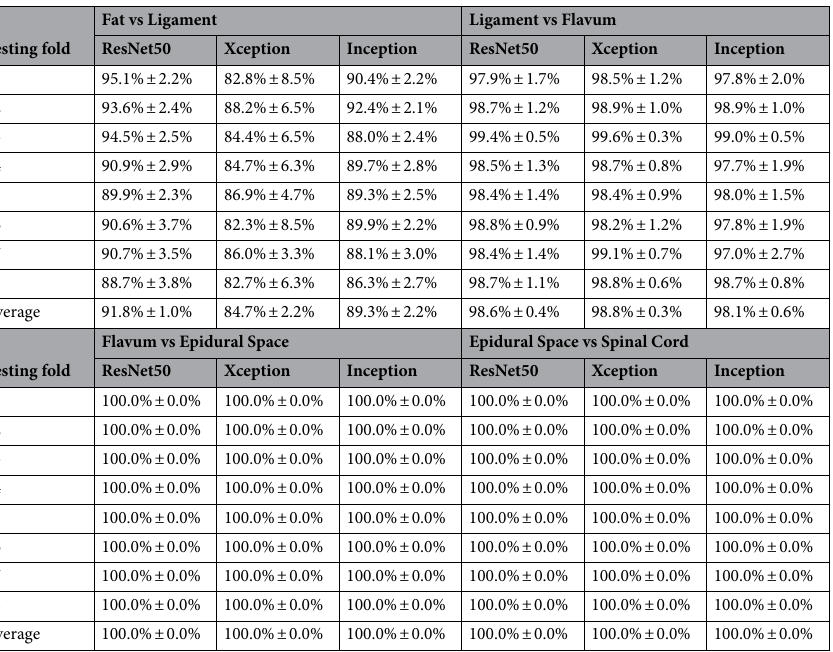
Table 1. Average accuracies and standard error based on the practical tissue layer sequence during puncture for cross-validation.